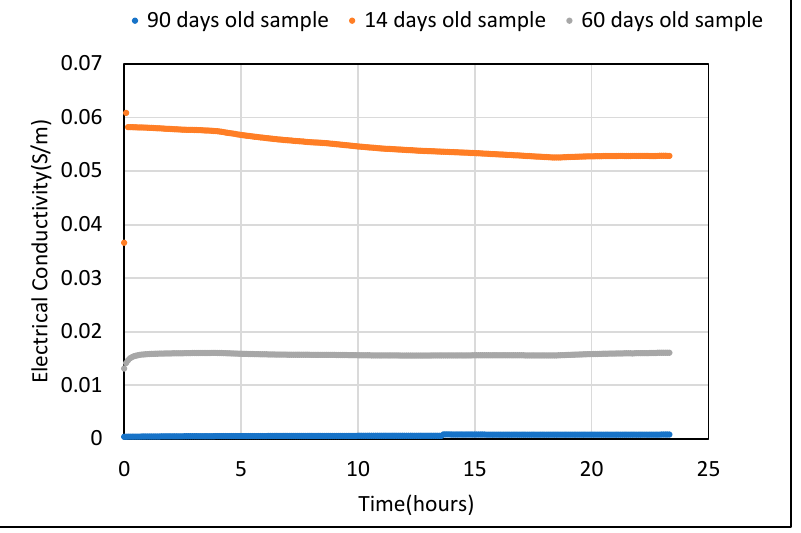
Figure 7. Electrical conductivity of control sample with 0.45 w/c after 14, 60 and 90 days.